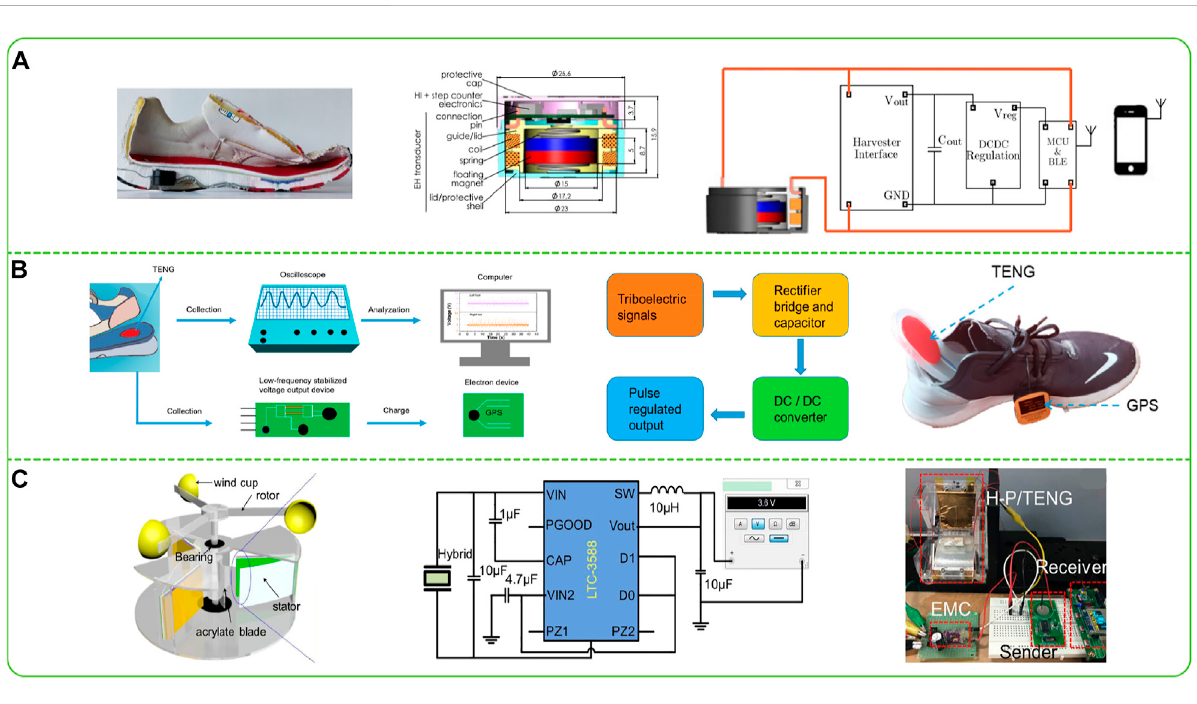
FIGURE 9 Traditional sensor based self-powered IoT systems. (A) Layout, implementation, and system architecture of the self-supplied step-counter (Bonisolietal.,2017). (B) Schematicdiagram,workingmodules,andimplementationoftheproposedportablemobilegaitmonitorsystem(Maoetal., 2021). (C) Schematic illustration, circuit diagram, and experimental setup of the H-P/TENG (Zhao C. et al.,